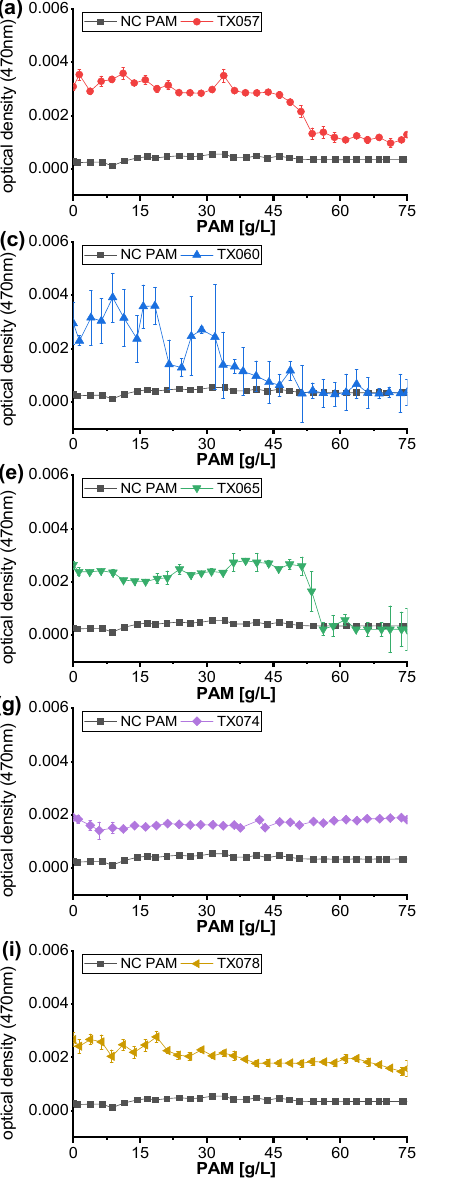
Figure 7. Dose-response curves of isolated Achromobacter spanius strains TX057, TX060, TX065, TX074 and TX078 against 10 kDa PAM. ( a , c , e , g , i ) show the optical density of the segments measured by microphotometry and ( b , d , f , h , j ) show the normalized autofluorescence of the segments measured by microfluorimetry. Each dot represents the mean and the error bars represent standard deviation of 10 ± 3 droplets.